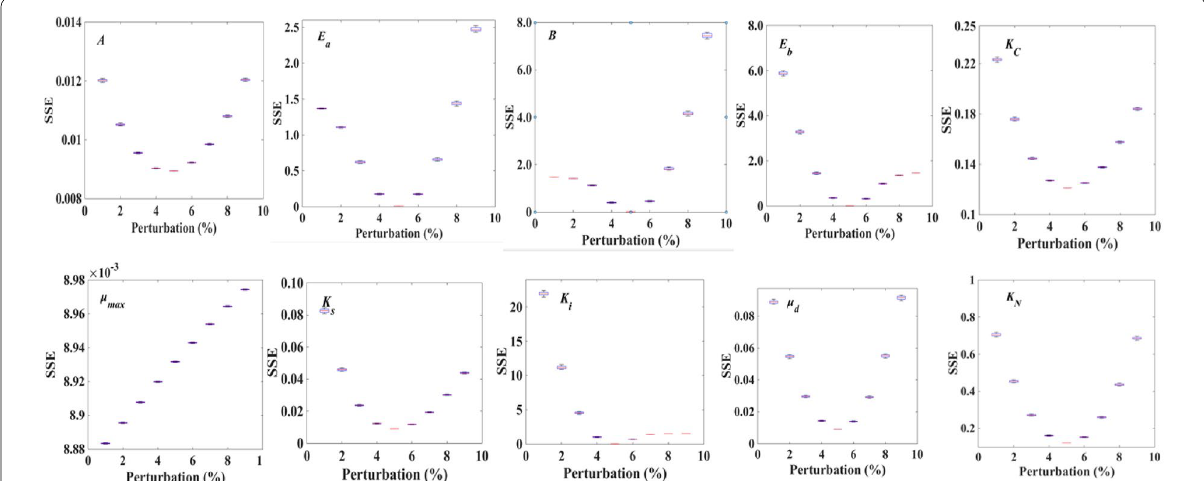
Fig. 3 Optimization of model parameters for cell growth in D. salina (optimized by MATLAB). SSE: system squared error. Where A and B are the coefficients before the index, E a is the activation energy for cell growth, E b is inactivation energy of cell growth, K C is carbon half-velocity constant, µ max is maximum cell-specific growth rate, Ks is light saturation value produced by cell growth, K i is photoinhibition value of cell growth, K N is the nitrate half-velocity constant,